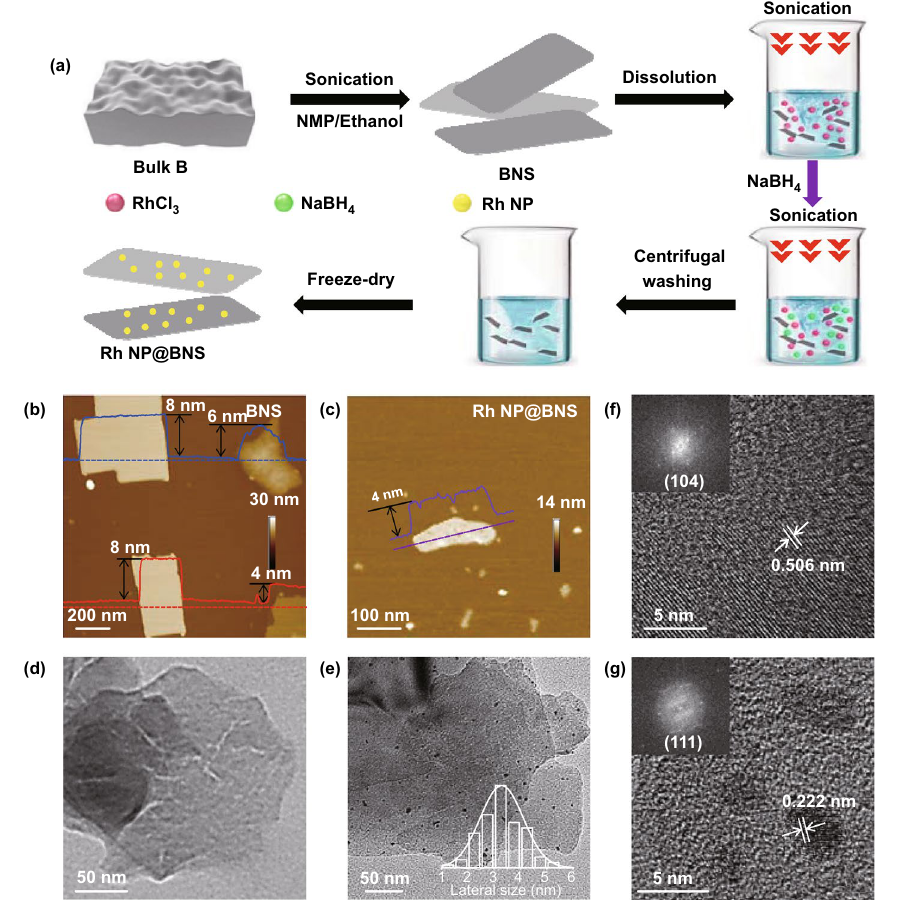
Fig. 1 a Schematic illustration of the preparation of 2D BNS and Rh NP@BNS. b, c AFM images, d , e TEM images (inset: lateral size distribu- tion of Rh NP), f , g high-resolution TEM images of Rh NP@BNS (inset: the corresponding FFT